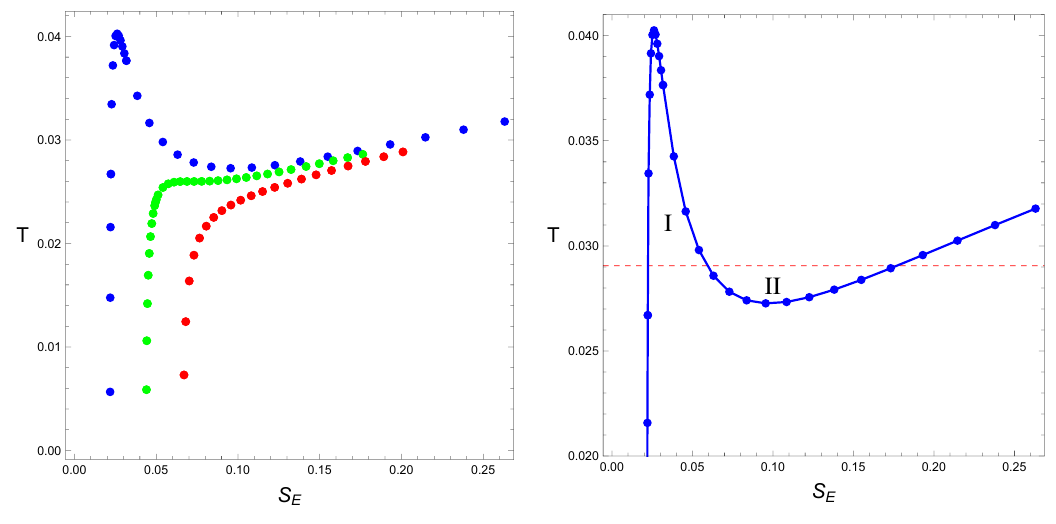
Figure 3 . T - S E diagram for a d = 4 charged AdS black hole. On the left we see the oscillatory behavior for Q < Q crit (blue) and the point of in(cid:13)ection for Q = Q crit (green). On the right the Maxwell construction for entanglement entropy for Q < Q crit is shown; it was claimed in [5] that Areas I and II as shown are equal above and below the phase transition temperature of the black hole T (cid:3) , given by the solid line. The paramaters chosen were l = 10, (cid:18) 0 = 0 : 15, and (cid:18) c = 0 : 149. Again, the values of Q are Q = 0 : 5 Q crit (blue), Q = Q crit (green) and Q = 1 : 5 Q crit